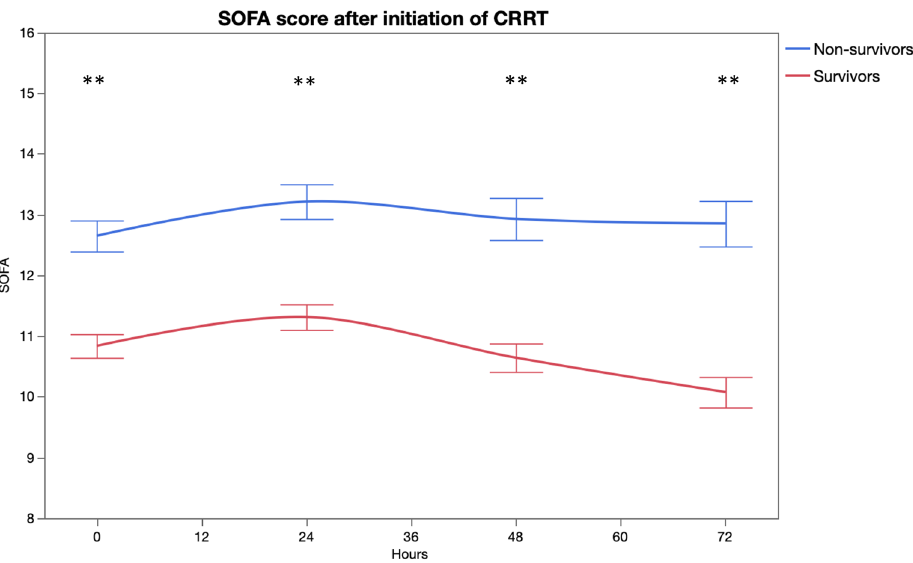
Figure 4. SOFA score by time (*p < 0.01, **p < 0.001). The figure was generated using JMP Pro 15.1.0 software. Copyright 2019 © SAS Institute Inc. JMP Pro and all other SAS Institute Inc. product or service names